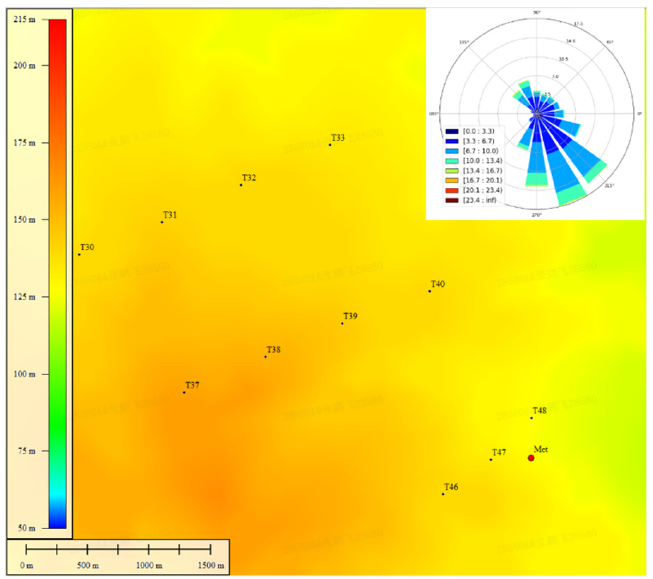
Figure 7. The actual location map of the met mast and the wind turbines.